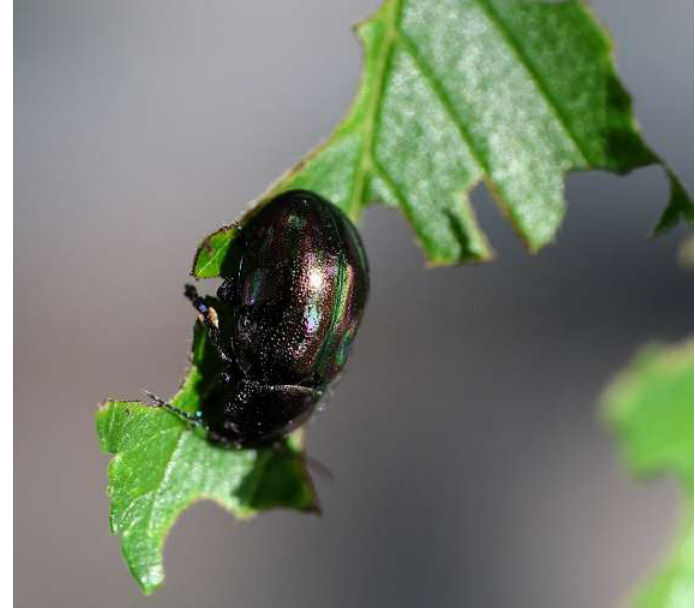
Figure 4. Ambrostoma superbum on a leaf of Ulmus pumila